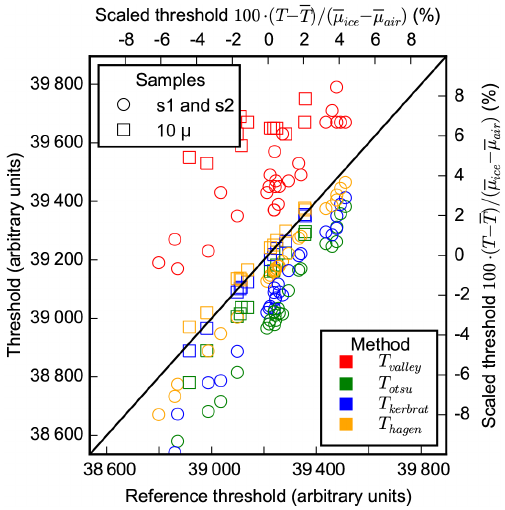
Figure 9. Sequential filtering segmentation: threshold values ob- tained on the entire set of images by the different intensity models. The black line represents the 1:1 line. The obtained thresholds T are also expressed as a function of the mean threshold T and the mean contrast µ ice – µ air between air and ice, obtained by the refer- ence